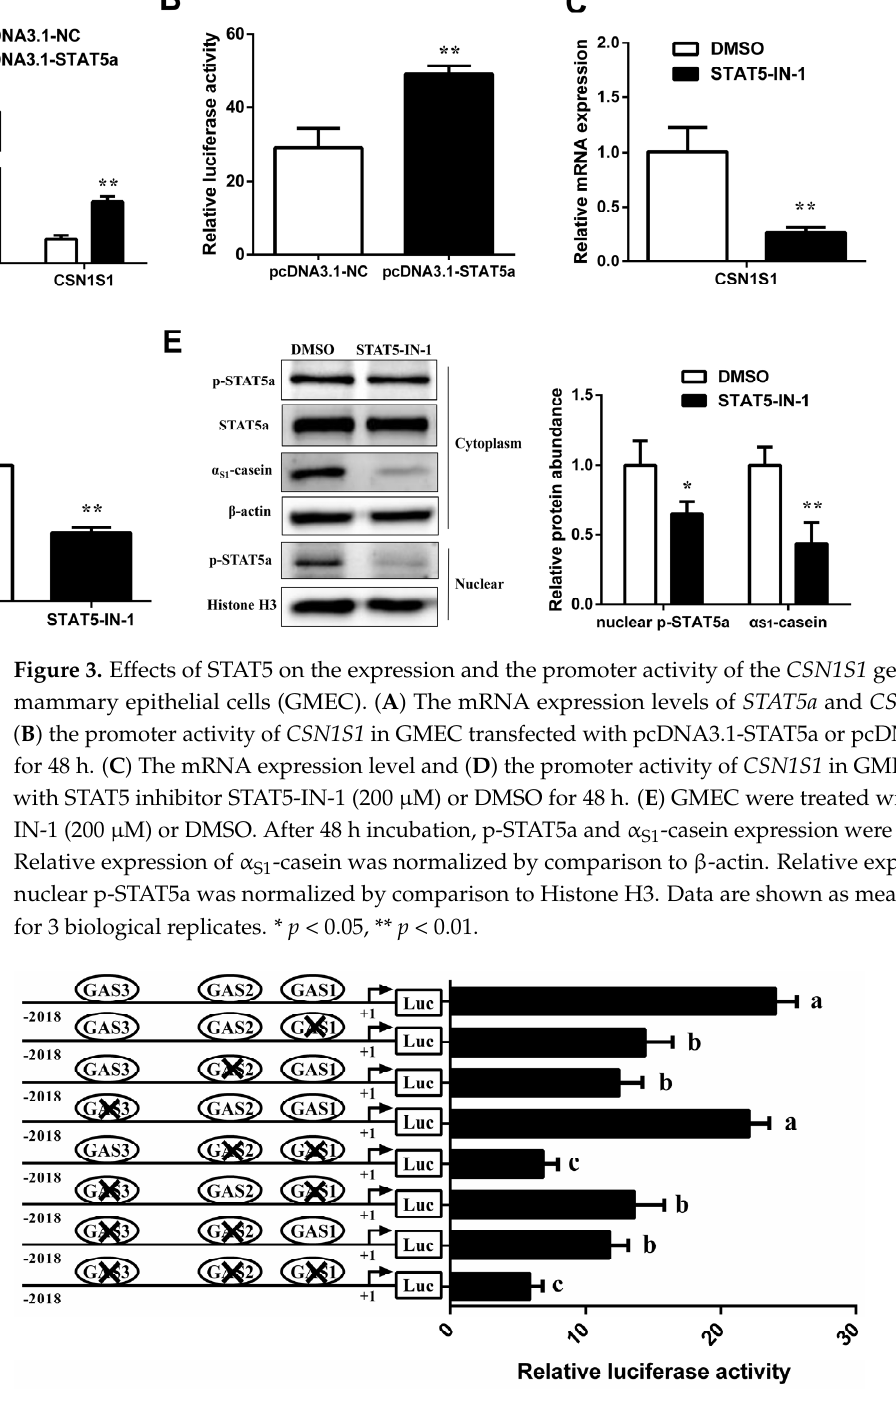
Figure 4. Relative luciferase activities of mutagenesis of STAT5 binding sites (GAS) in the CSN1S1 promoter region. Data are shown as means ± SEM for 3 biological replicates. Differences between 2 groups are considered significant at lowercase letters, p < 0.05.